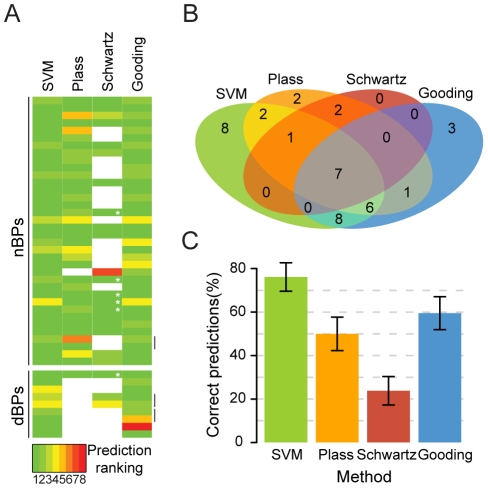
Benchmarking on a set of experimentally verified BPs.
A – Ranking of experimentally verified BPs according to 4 predictive methods. Blank cells represent BPs that either did not match the initial sequence requirements or that are located outside the search region. Though Schwartz method in several introns ranks the BP as 1st, the prediction is discarded because it is not the candidate closest to the 3SS (white asterisks). B – Correct predictions overlap between methods. C – Percentage of introns in which each method was capable of correctly predicting the BP. The error bars represent the standard error given by the formula:  where  is the probability and n the overall sample size.